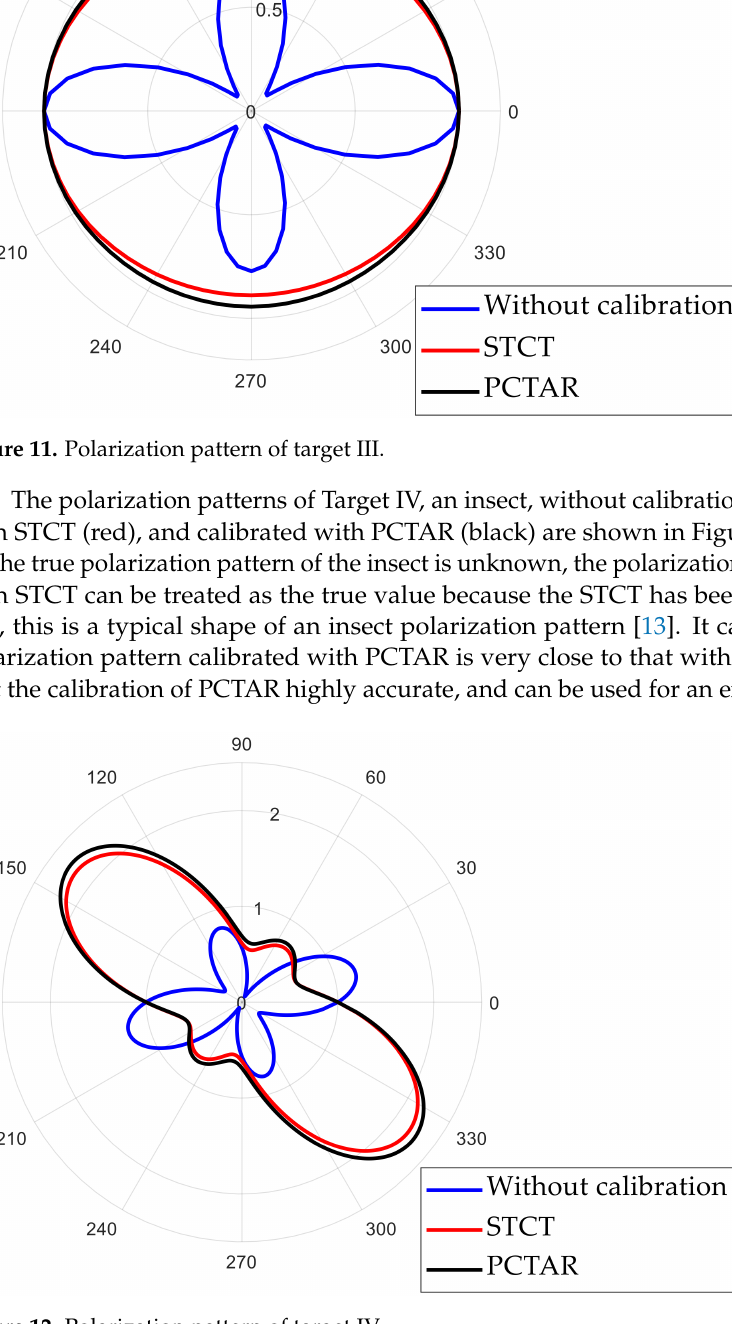
Figure 12. Polarization pattern of target